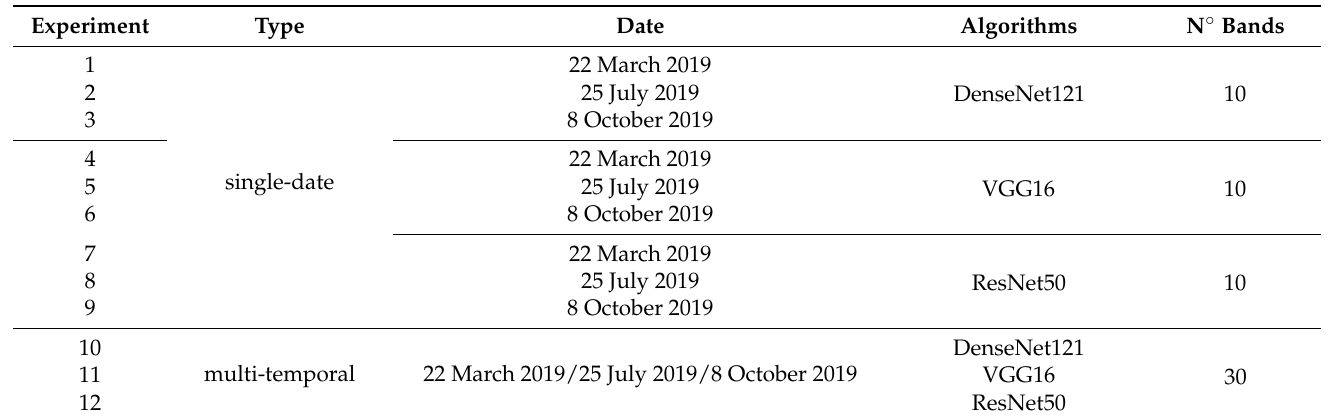
Table 3. Main characteristics of the experiments performed by applying the three classification algorithms to the four multiband